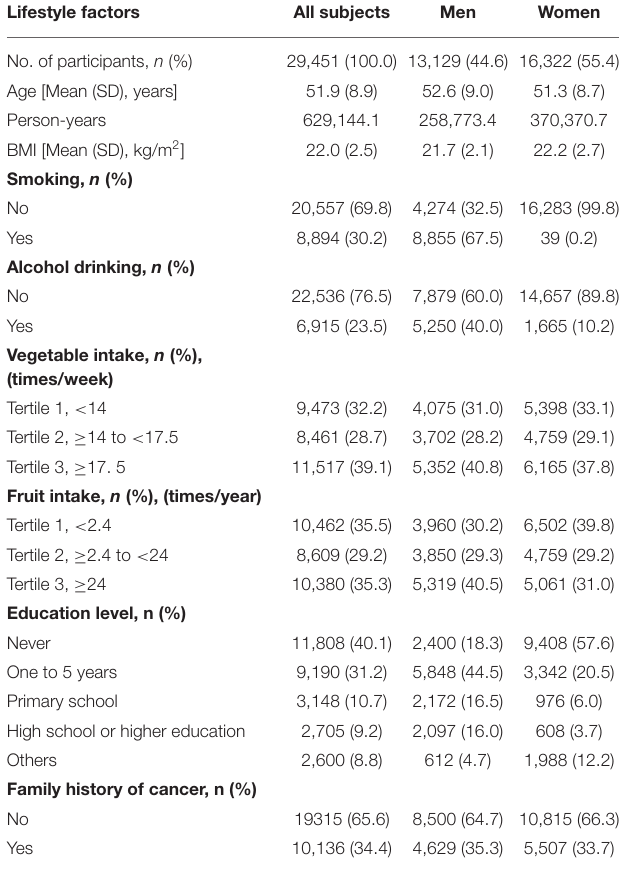
TABLE 1 | Baseline characteristics in the Linxian General Population Nutrition Intervention Trial Cohort. Lifestyle